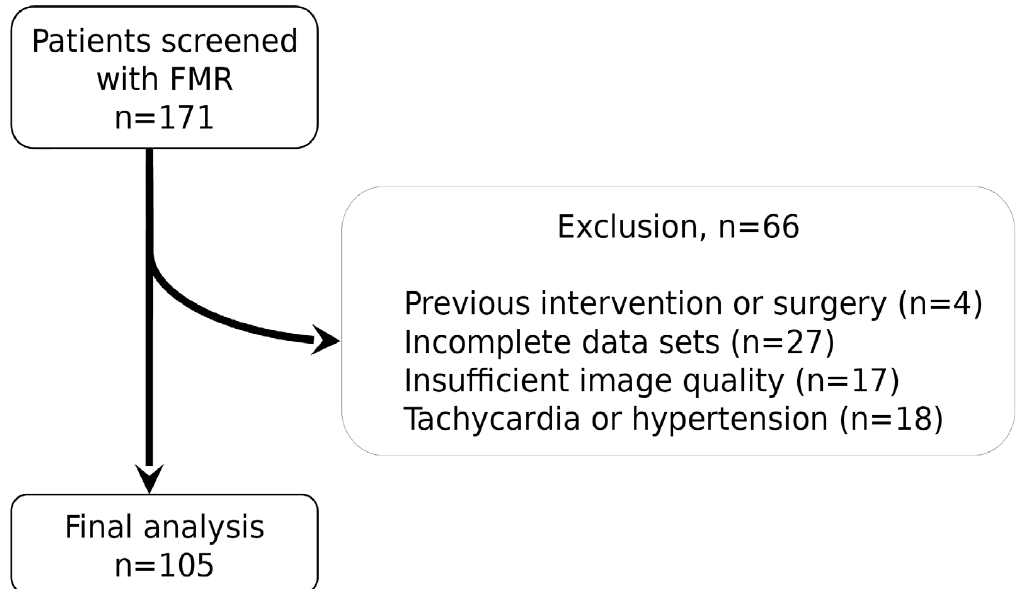
Figure 1. Screening procedure of patients with symptomatic moderate to severe FMR as part of the collective of patients enrolled in the “Dresden Mitral Valve Registry”. Abbreviation: FMR = functional mitral valve regurgitation.